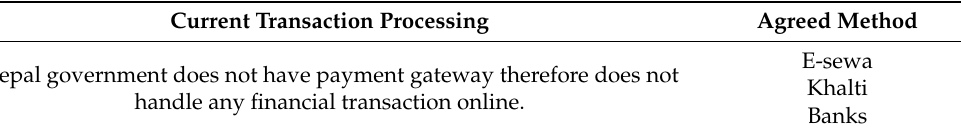
Table 6. Electronic transaction processing